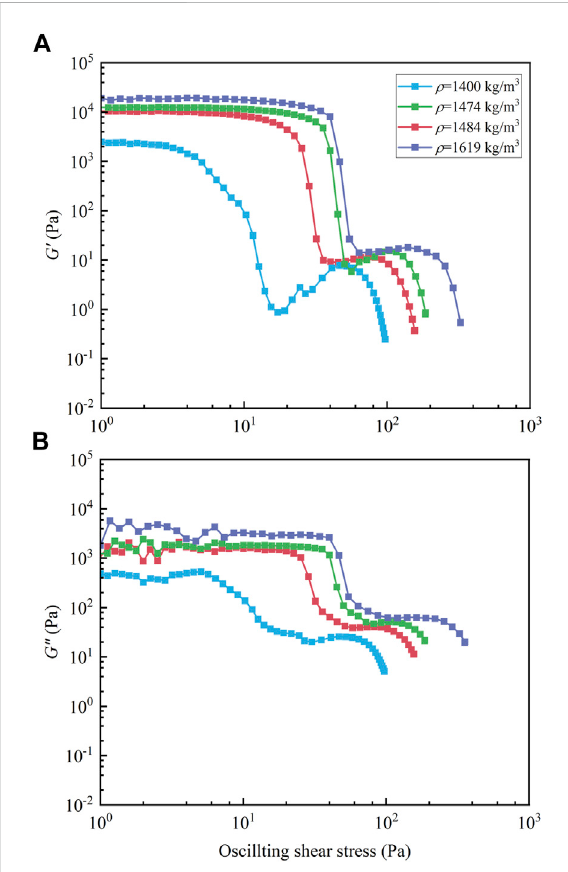
FIGURE 9 Results of oscillatory stress sweep tests for different